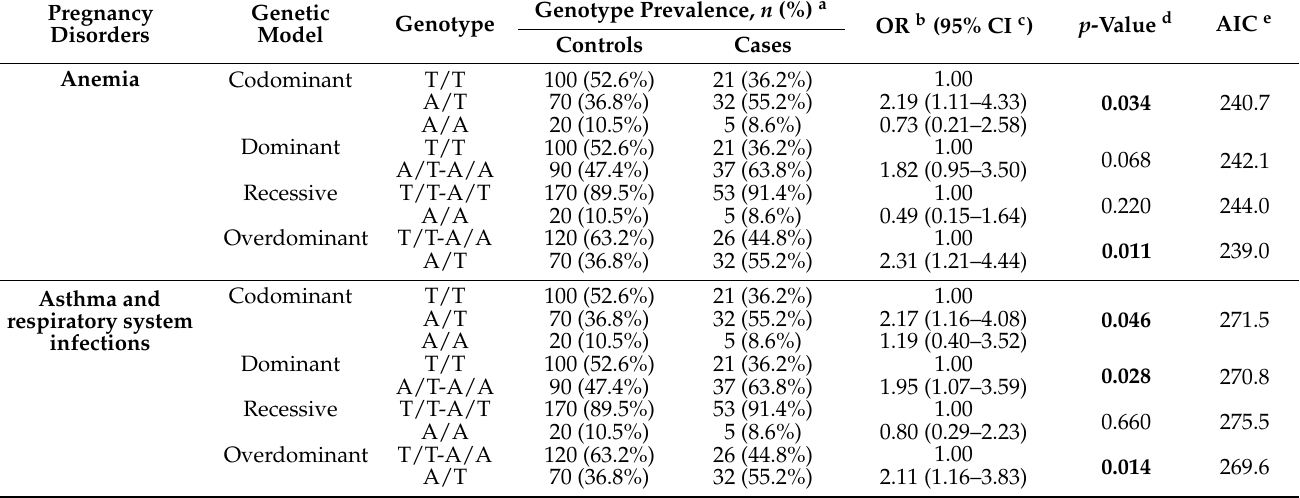
Table 4. Association of HLX rs868058 genotypes with early-onset fetal growth restriction, corrected for adverse pregnancy